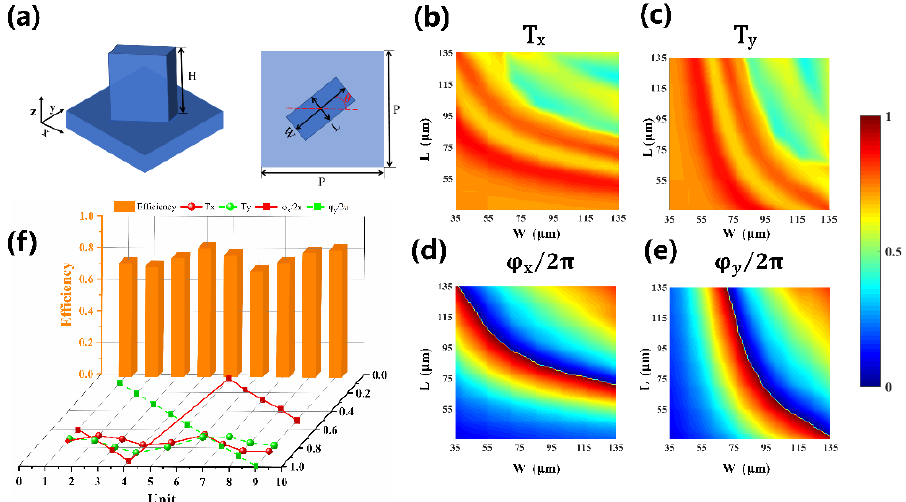
Figure 4. ( a ) Schematic of the rectangular-shape silicon pillar: the lattice constant P, the length L, the width W, and the height H, respectively. The angle 𝜃 represents the rotation of the unit cell. ( b – e ) Simulated transmittance and phase shift as a pillar sizes (L, W) function under x-polarized and y-polarized illumination at 0.75 THz, respectively. ( f ) Transmittances, phase shifts, and polarization conversion efficiencies of the nine selected unit cells. Table 1. Geometric parameters and polarization conversion efficiency for the selected unit cells.